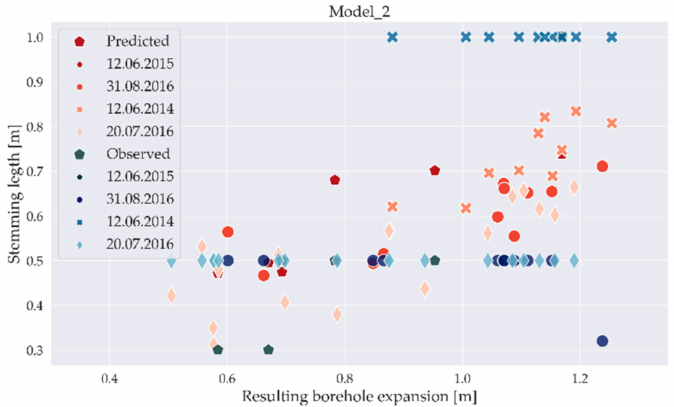
Figure 11. Model_2—Stemming length vs. resulting borehole expansion.